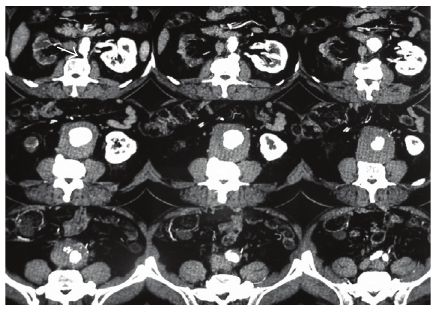
Figure 1: Cross-sectional CT scan demonstrates large abdominal aortic aneurysm compressing Inferior Vena Cava (IVC). The arrow points to juxta-renal IVC, the arrow head points to the virtually occluded IVC, and the line to the thrombosed common iliac veins.